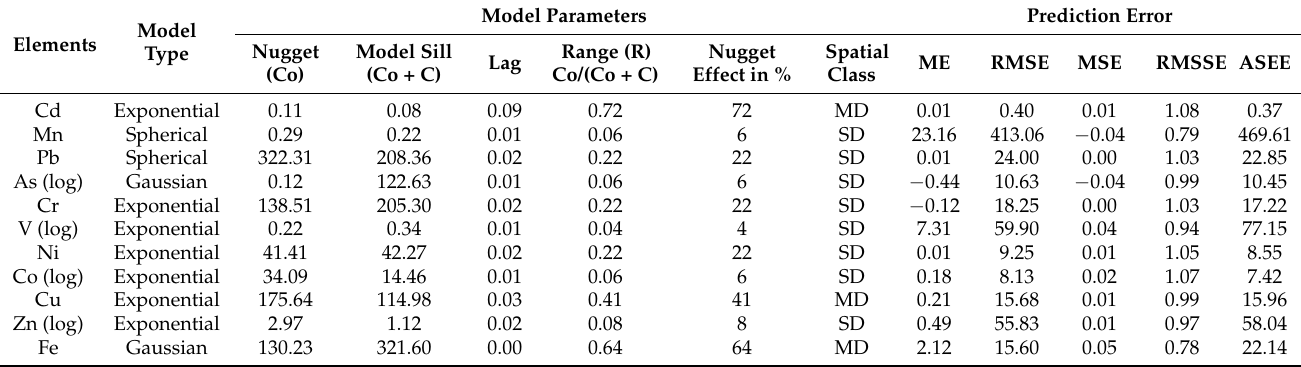
Figure 4. Distribution of ( A ) Cr, ( B ) Ni, ( C ) Pb, ( D ) Cd, and ( E ) As (mg/kg) with respect to mining sites and urban land use. The NE% results ranged from 4% (for V) to 72% (for Cd). The range of the semi- variogram models varied in decreasing order from Cd to Fe, Cu, Pb = Cr = Ni, Zn, Mn = As = Co, and V (Table 5). Table 5. Semi-variogram models and their parameters for heavy